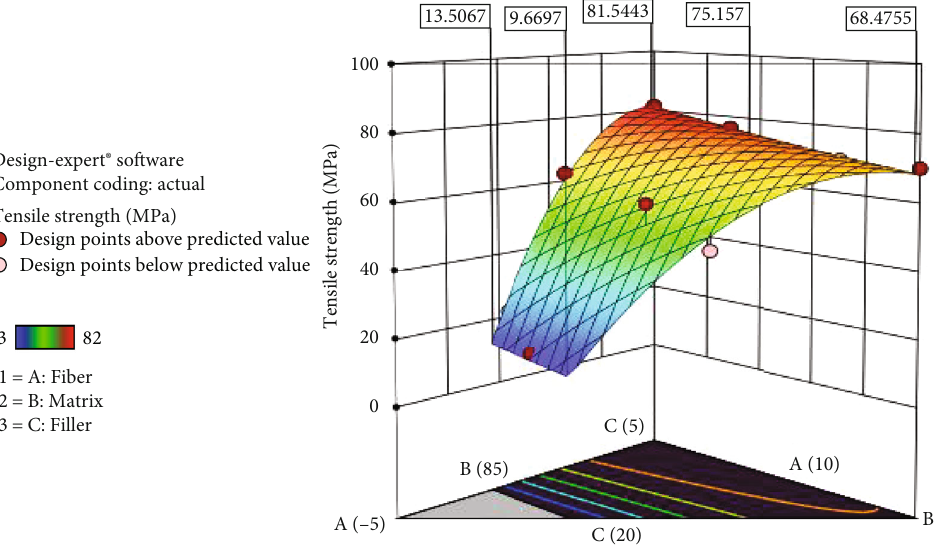
Figure 9: The e ff ect of fi ber, matrix, and fi ller weight % on tensile strength.